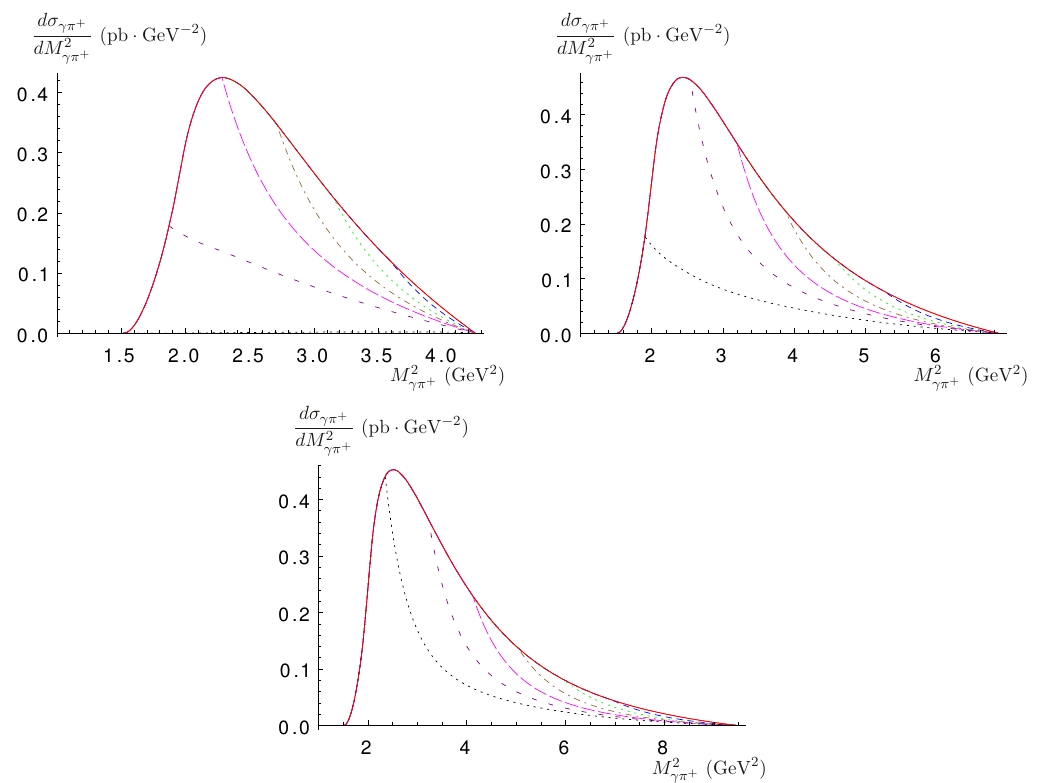
2 Figure 15 . The differential cross section dσ for γπ + pair production on a proton γπ + /dM γπ + target. Solid red: no angular cut. Other curves show the effect of an upper angular cut θ for the out-going γ : 35 ◦ (dashed blue), 30 ◦ (dotted green), 25 ◦ (dashed-dotted brown), 20 ◦ (long-dashed magenta), 15 ◦ (short-dashed purple) and 10 ◦ (dotted black). Up, left: S γN = 10 GeV 2 . Up, right: S γN = 15 GeV 2 . Down: S γN = 20 GeV 2